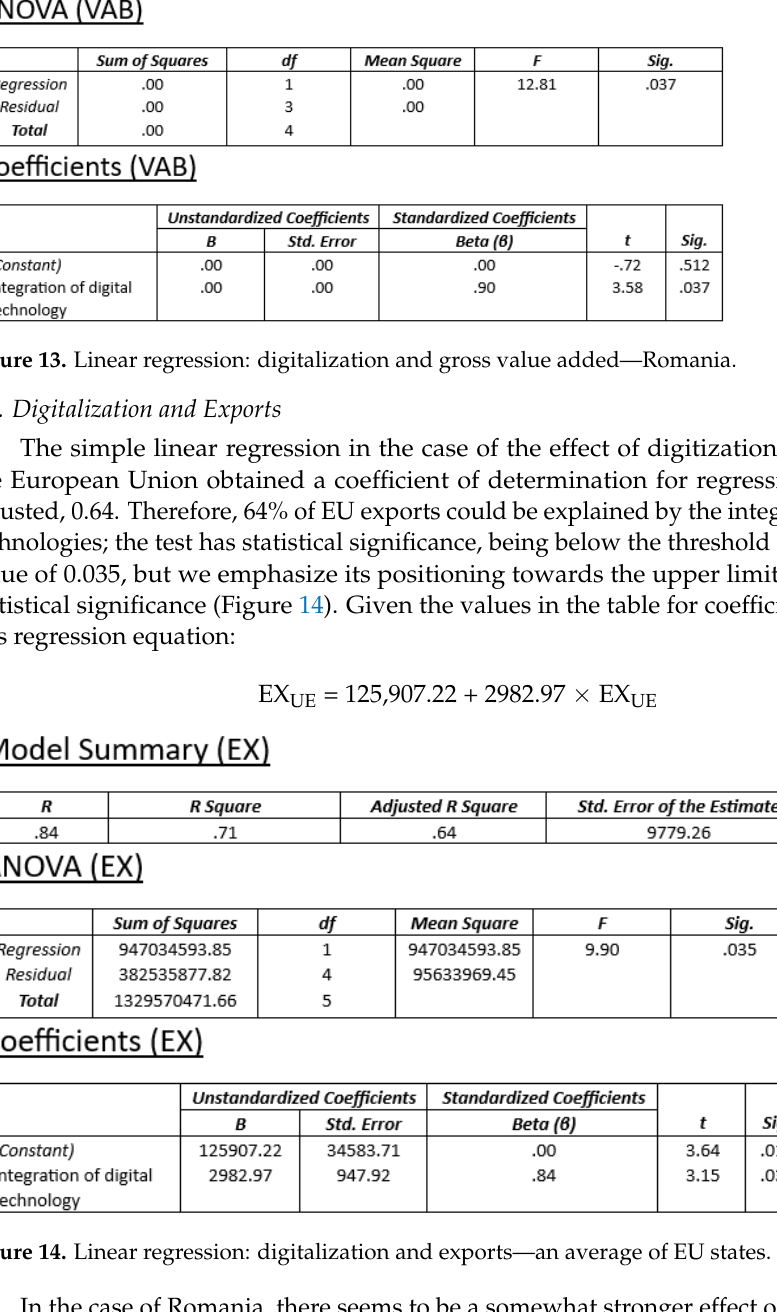
Figure 12. Linear regression: digitalization and gross value added—an average of EU states.